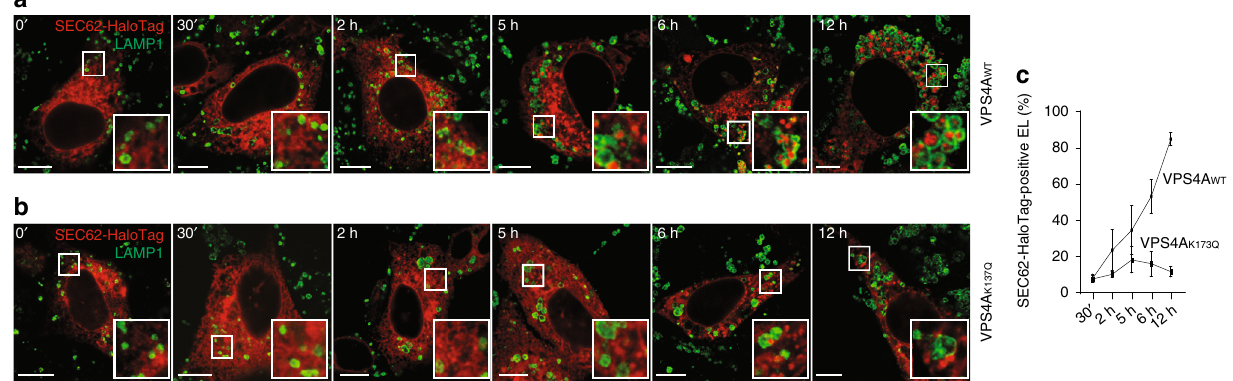
Fig. 7 Time-resolved analyses of VPS4A-dependent delivery of EV within EL. a Cells expressing SEC62-HaloTag and VPS4A WT are incubated for 30 min with 6-chlorohexanol, a non- fl uorescent HaloTag ligand that quenches fl uorescent detection of the SEC62-HaloTag chimera. Cells are subsequently incubated with a cell-permeable fl uorescent HaloTag ligand (PBI 5030) to label, for 15 min, newly synthesized SEC62-HaloTag ( fl uorescent pulse). Cells are fi xed at different times after interruption of the fl uorescent pulse on PBI 5030 replacement with 6-chlorohexanol (0 to 12 h 19 ) to monitor the progressive delivery of SEC62-HaloTag-labeled EV within LAMP1-positive EL. b Same as a in MEF expressing SEC62-HaloTag and VPS4A K137Q , where EV delivery within EL is virtually abolished. c Quanti fi cation of SEC62-HaloTag positive EL (VPS4A WT n = 3, 3, 3, 4, 4; VPS4A K173Q n = 3, 3, 4, 4, 4 cells for the corresponding time points). Mean± SEM. IF panels are representative of two independent experiments. Scale bar: 10 μ